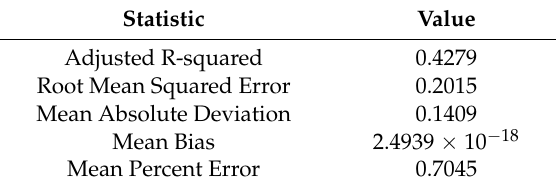
Table 7. Summary of the fit statistics for the final lumber visual grade model